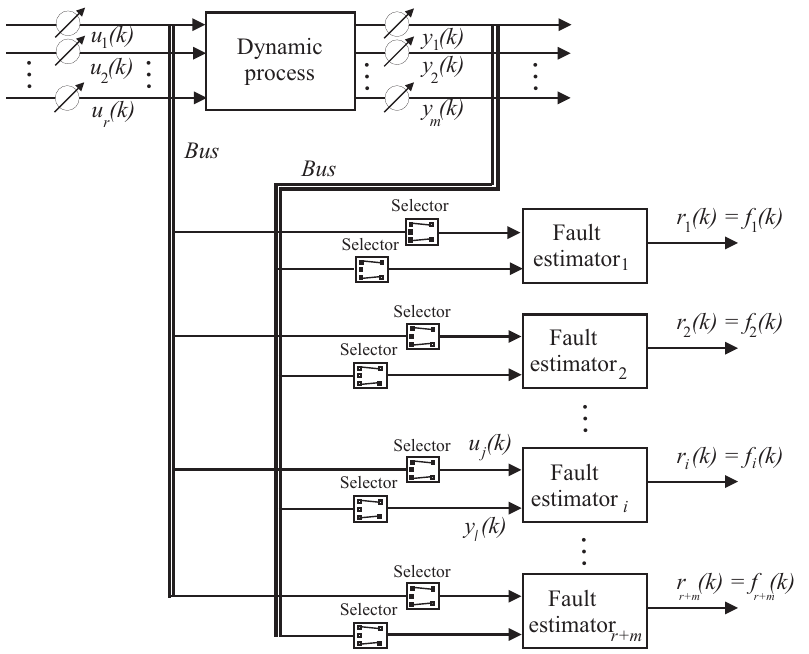
Figure 3. The estimator scheme for the reconstruction of the equivalent input or output faults f i ( t )